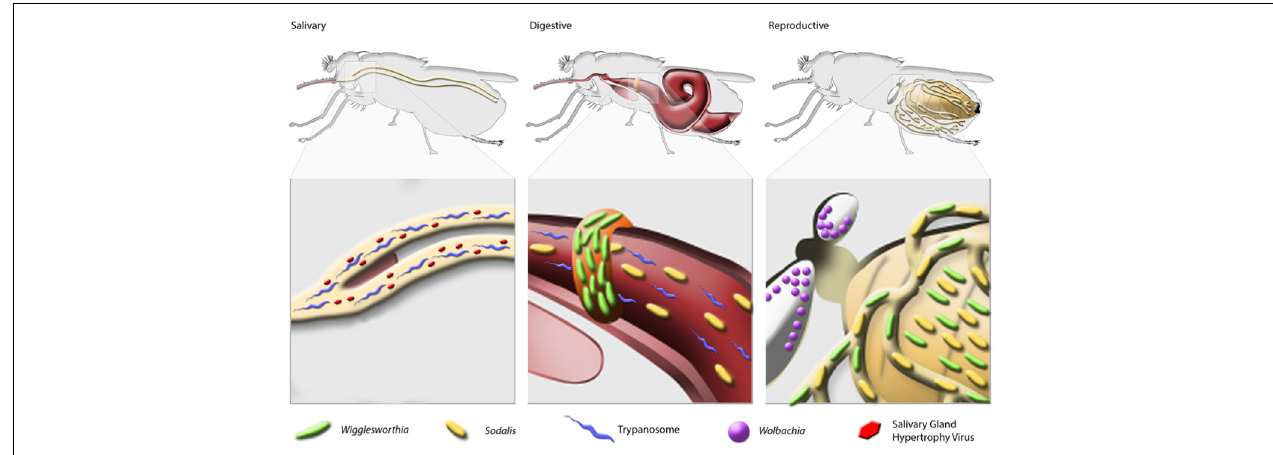
FIGURE 1 | Localization of symbionts and SGHV in